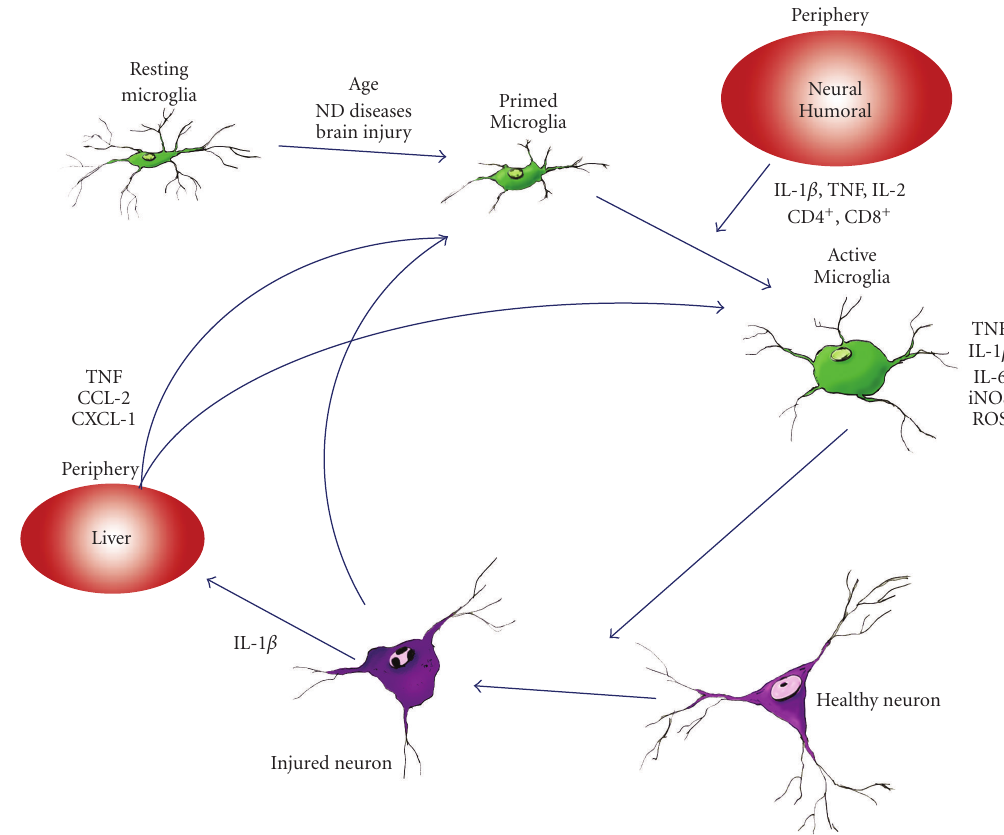
Figure 1: Schematic diagram showing the relationship between peripheral inflammation and neuronal loss in PD. Neurodegenerative diseases present microglial activation as the main hallmark, which can change its morphology from resting (ramified) towards an activated round shape (ameboidal). The intermediate stage, “primed microglia”, describes the atypical microglial stage, which precedes a further neurotoxic microglial activation as a consequence of a secondary pro-inflammatory stimulus. This stimulus can come from the periphery, either through neural or humoral pathways. Activated microglia release pro-inflammatory cytokines which can act on neuronal integrity. In addition, acute brain injury induces early hepatic expression of chemokines, which in turn produce recruitment of leukocytes into the blood and subsequently brain and liver inflammation via a chemokines and cytokines